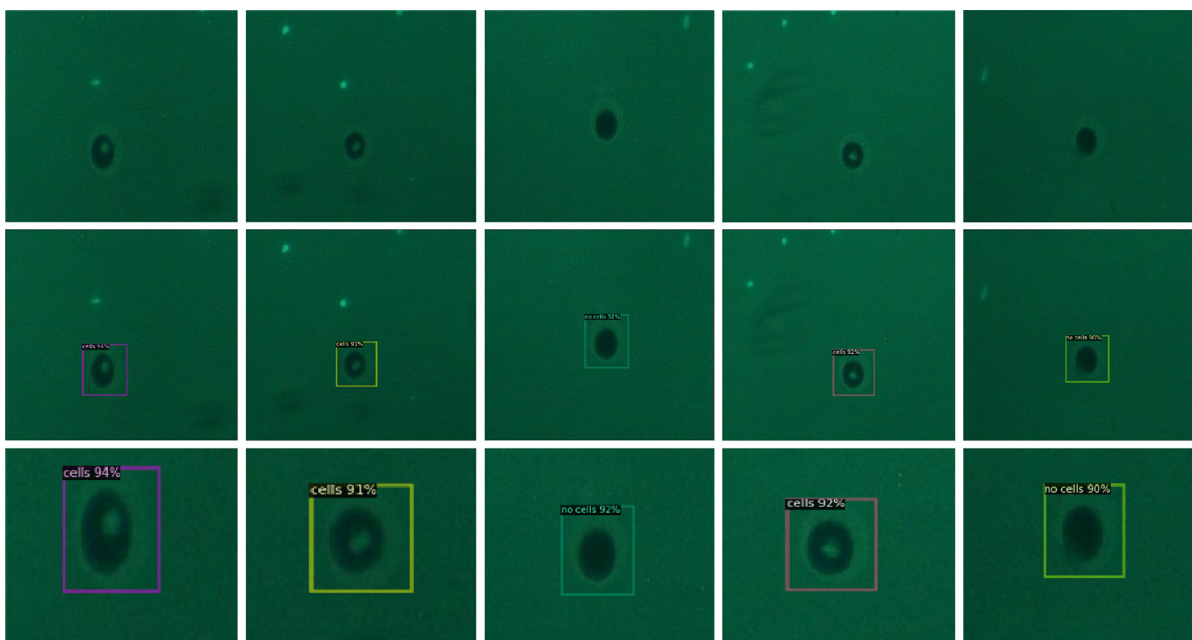
Figure 9. The detection obtained from RetinaNet. We have considered an ROI (Region of Interest) threshold of 0.85 and tested the results via CPU for visualization. This also ensures the compatibility of the method in resource-limited environments. (Top) The original images were put into the DL model for testing. (Middle) The results depict the region of interest and the location of the microwell. In addition to that, the model is classifying the images based on whether the microwell patterns contain cells or not. (Bottom) An enlarged sectional view of the detected microwells. The last row of images clearly shows the labels associated with each of the microwells, as detected in the middle -row